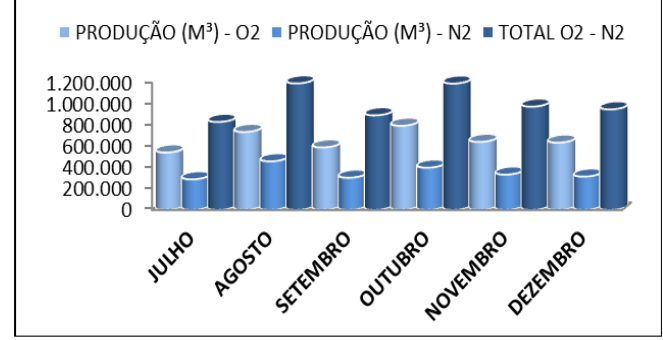
Figura 5. Produção O